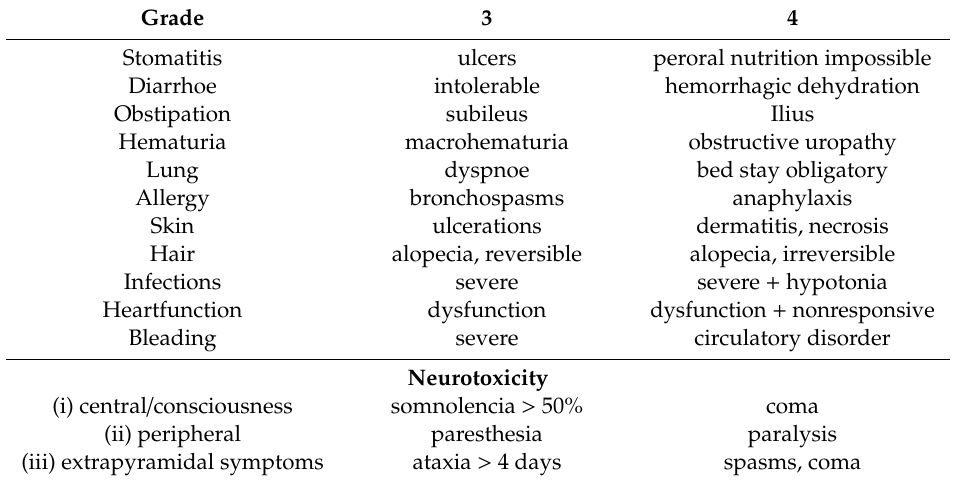
Table 2. Other signs of toxicity of approved cytostatic drugs according to WHO